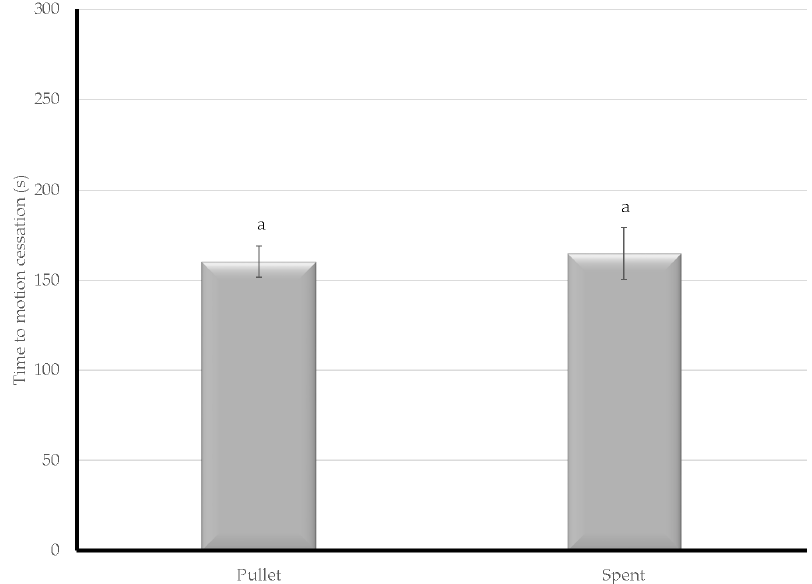
Figure 3. The time from treatment to cessation of movement was evaluated using a second CAFS system with birds of differing ages. Letters denote assigned connected letters report with differing letters representing statistical significance.